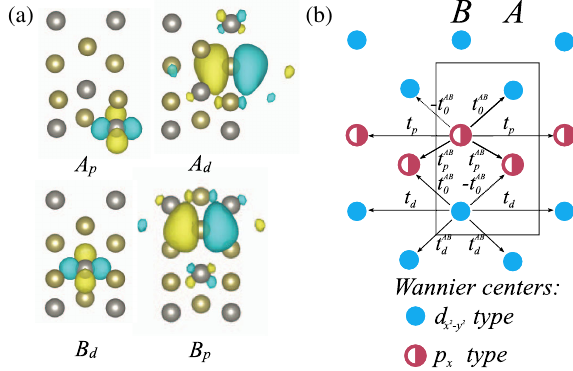
FIG. 10. (a) Plots of the Wannier functions obtained by a 4- band Wannier interpolation. The functions are labeled by their orbital character l ¼ d , p and their sublattice index A , B . Gray spheres represent M atoms, whereas as ochre spheres represent X atoms. (b) Symmetry-allowed hoppings considered for the tight- binding model. All hoppings are nearest-neighbor hoppings with the exception of the intrasublattice hoppings t symbols below the letter A (B) belong to the A (B) sublattice.